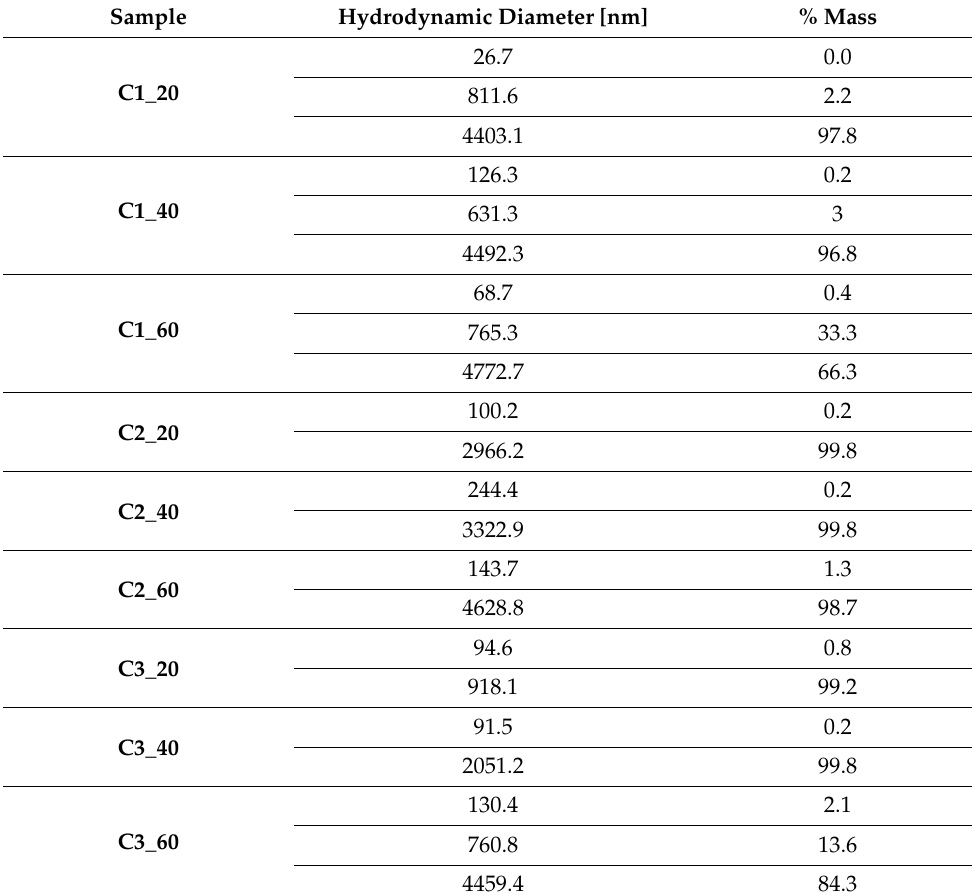
Table 3. The hydrodynamic diameters for the MNPs samples.